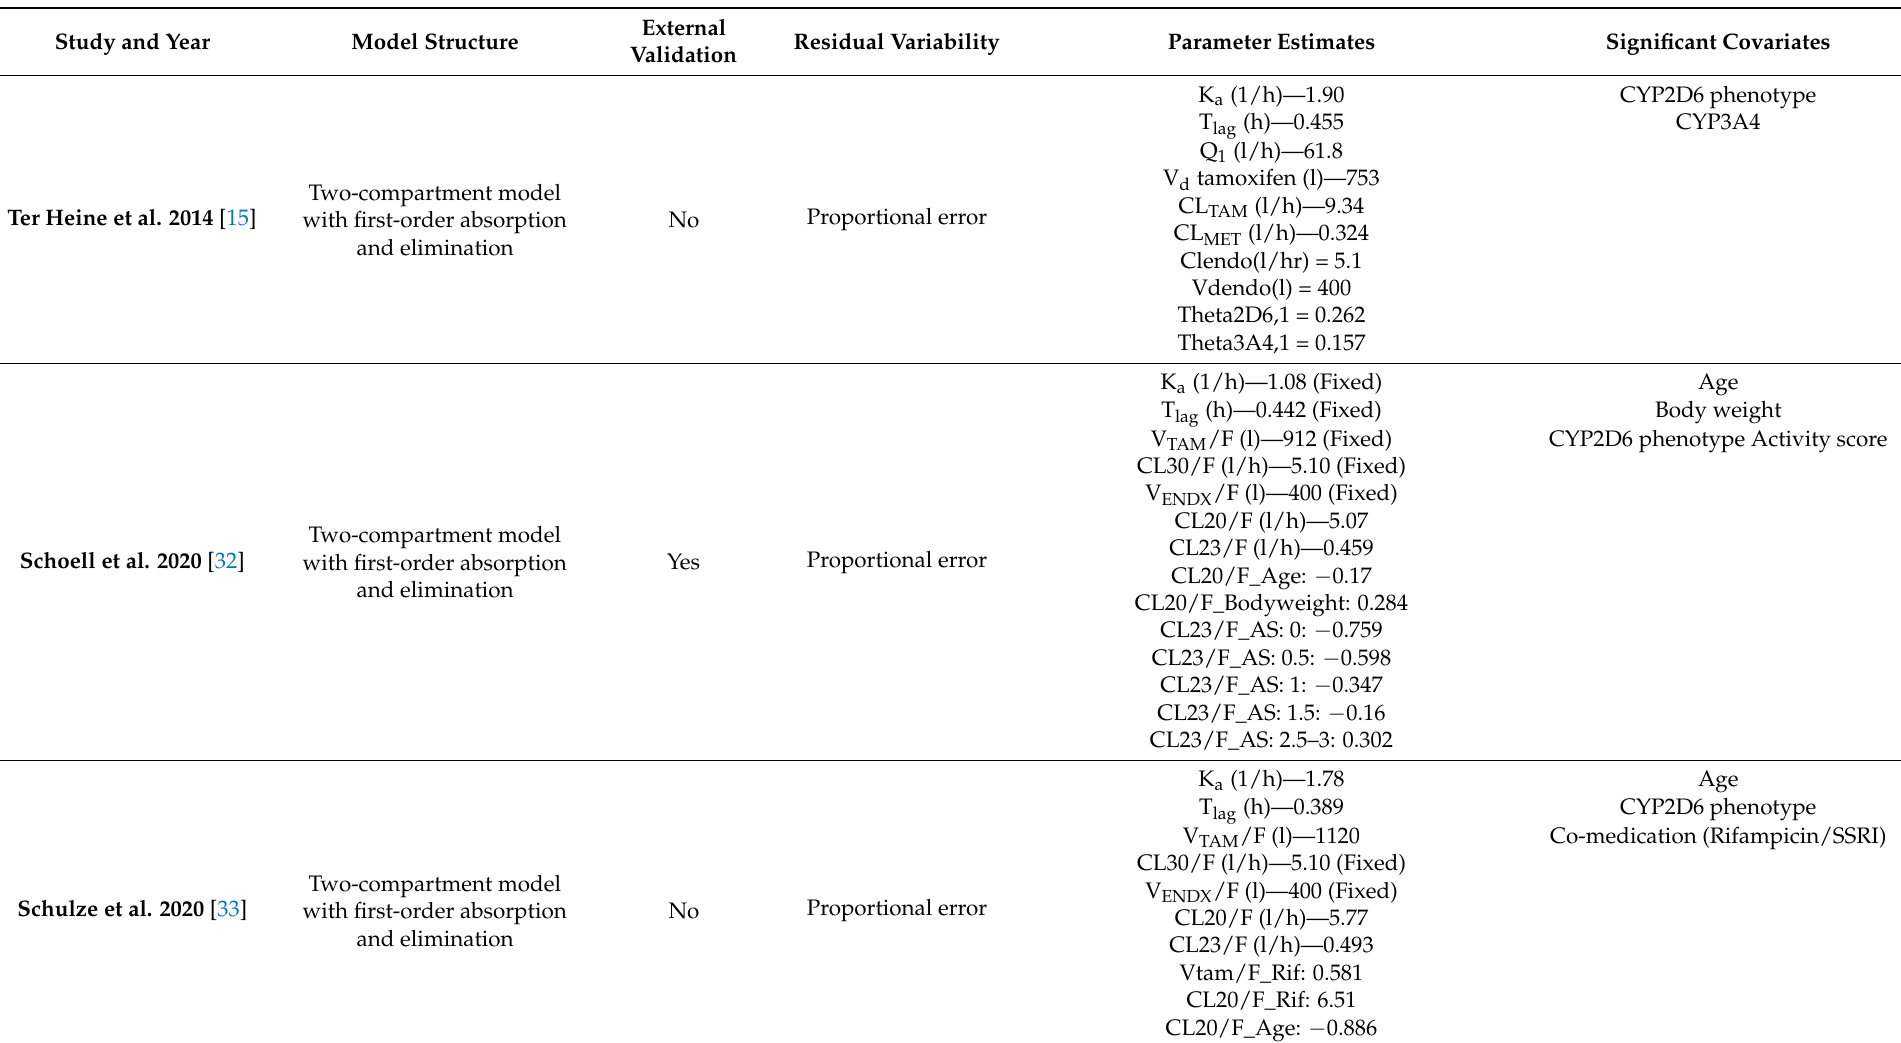
Table 3. Parameters of selected